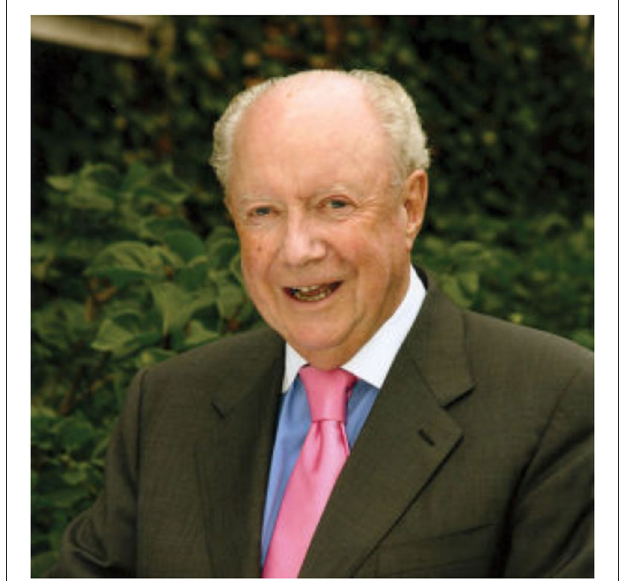
FIGURE 3 | Professor Barry O’Donnell MCh FRCS—Royal College of Surgeons in Ireland.